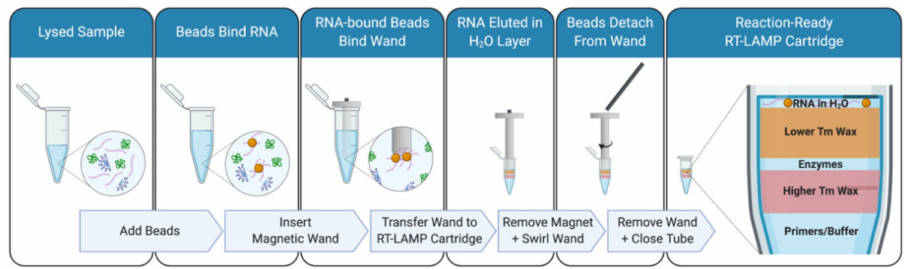
Figure 1. Sample concentration with magnetic wand and paramagnetic wand. The paramagnetic beads bind to viral RNA in the lysed sample. The magnetic wand is used (1) to collect these RNA- bound beads away from the rest of the sample volume and (2) to transfer them to the loop-mediated isothermal amplification (LAMP) reaction cartridge. To release the beads from the magnetic wand, the magnet is slid from the 3D-printed sheath. In the absence of a magnetic field, the paramagnetic beads are no longer magnetized and are able go into solution in water at the top of the LAMP reaction